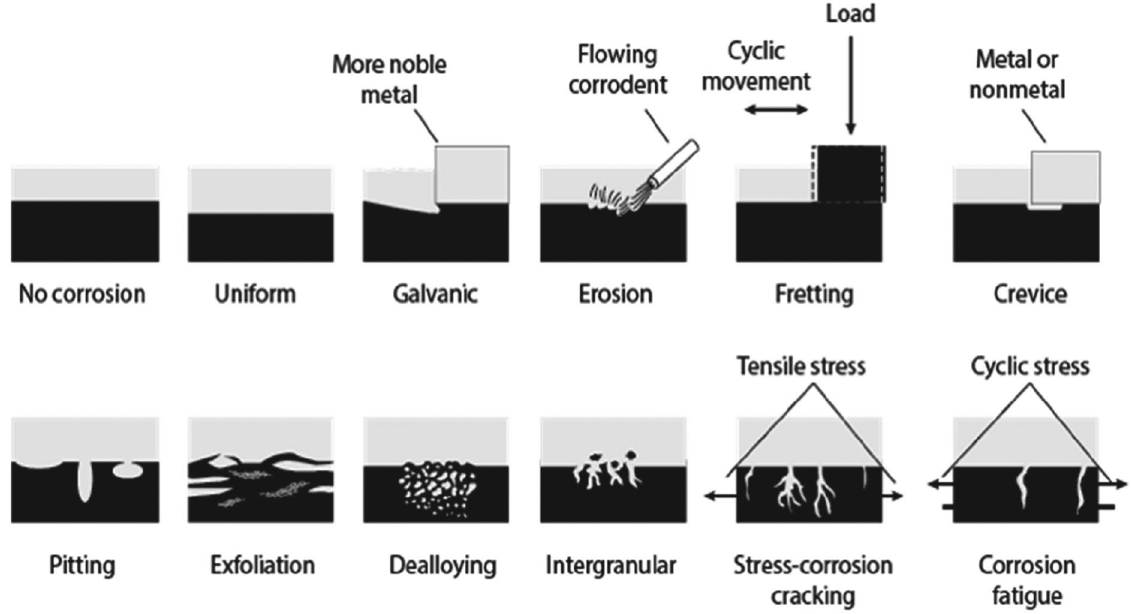
Figure 2. Different modes of corrosion